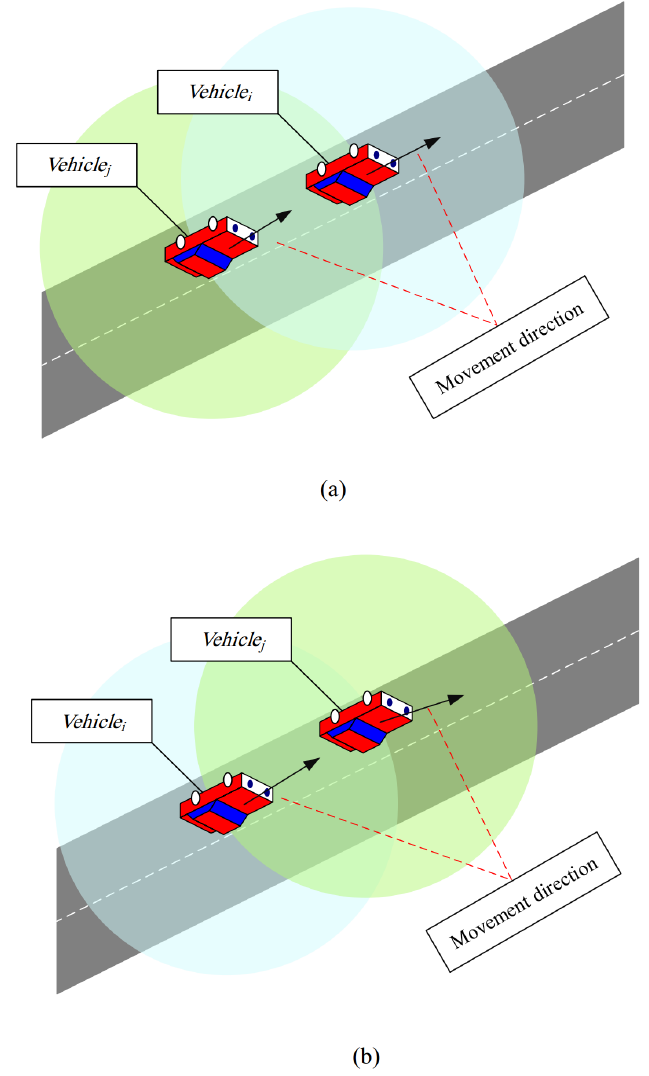
Figure 5. The movement of vehicles in the same direction ( a ) Vehicle i is ahead of Vehicle j . ( b ) Vehicle i is behind Vehicle j